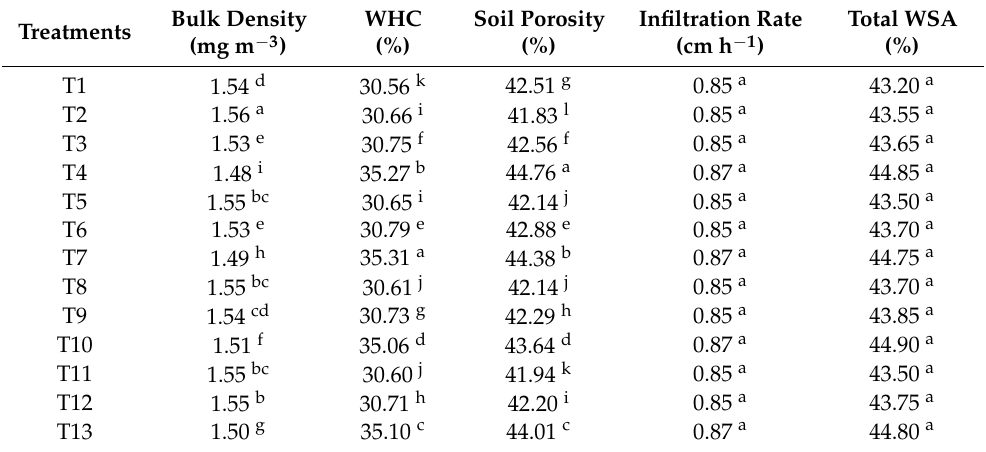
Table 1. Effect of different organic and inorganic treatments on mean value of soil physical properties.